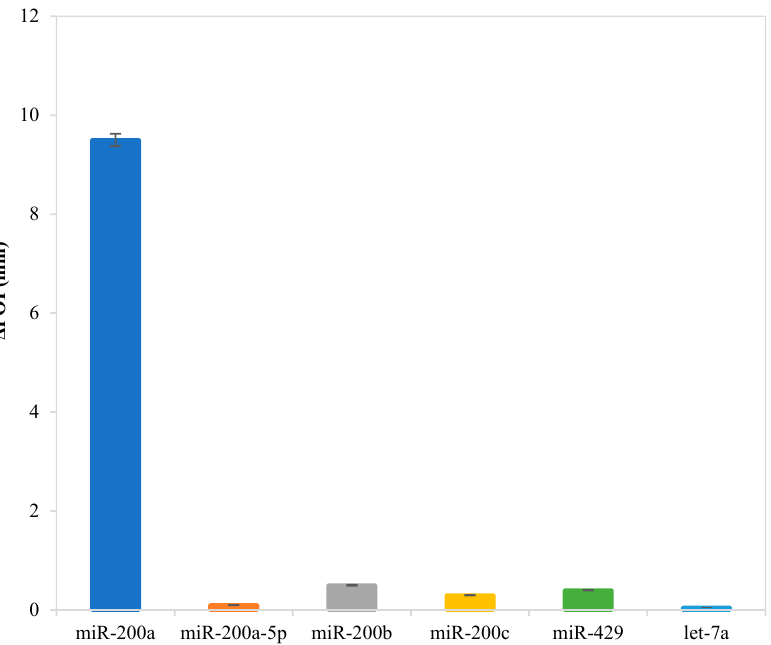
Figure 4. Selectivity evaluation of the RC-LAMP assay for miRNA detection. Experimental condi- tions: padlock probe 20 pmol/L, miR-200a / mismatch miRNA 10 fmol/L, T4 DNA ligase 70 U, FIP/BIP 800 nmol/L and amplification temperature 62 °C, respectively.